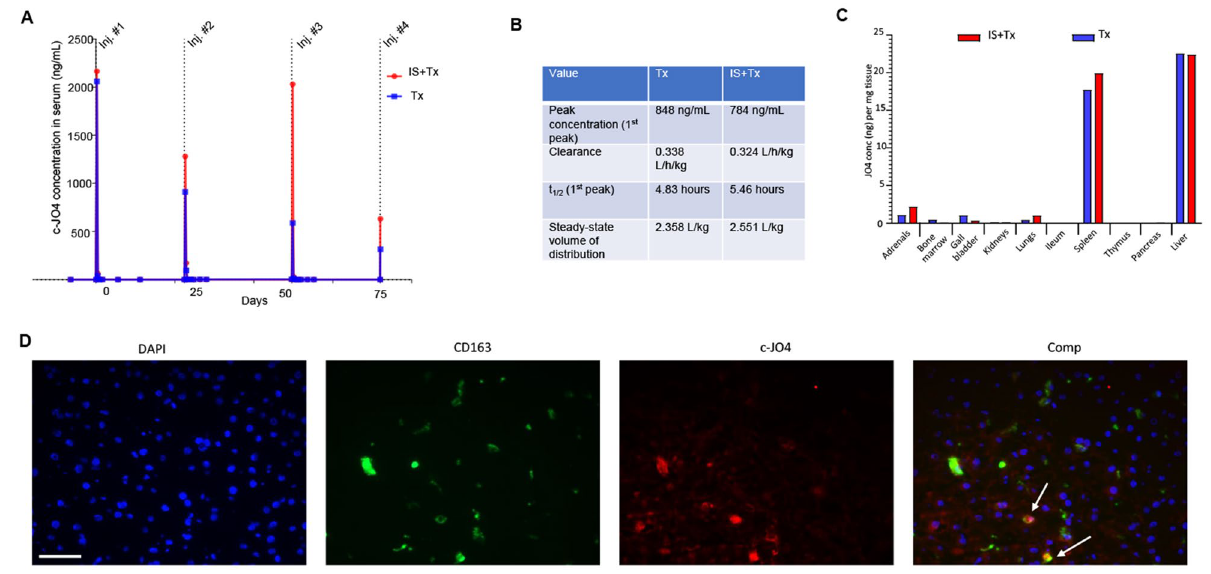
Figure 4. Non-GLP four-cycle toxicity /pharmacokinetics /immunogenicity study with c-JO4 + Doxil in cynomolgus monkeys. ( A,B ) c-JO4 pharmacokinetics. ( A ) c-JO4 concentration in serum collected at indicated time points as measured by ELISA. ( B ) Pharmacokinetics parameters. ( C ) c-JO4 concentration in it issues. Tissues were ground with QiaShredder and resulting tissue lysates were measured by ELISA for c-JO4. c-JO4 levels in tissue lysates were normalized for mg tissue. ( D ) Immunofluorescence with anti-CD163 and anti-cJO4 antibodies on liver sections of the “Tx” animal. Nuclei are stained blue with DAPI. The scale bar is 20 μm. In the composite panel (right) co-staining is marked by